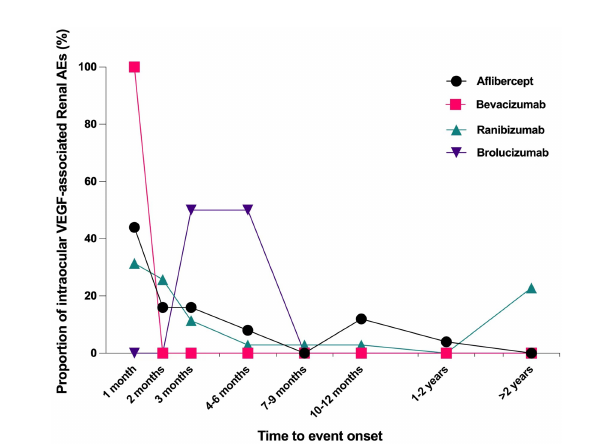
FIGURE 2 Time to event onset of renal adverse effects following intravitreal administration of anti-VEGF agents. VEGF, vascular endothelial growth factor.